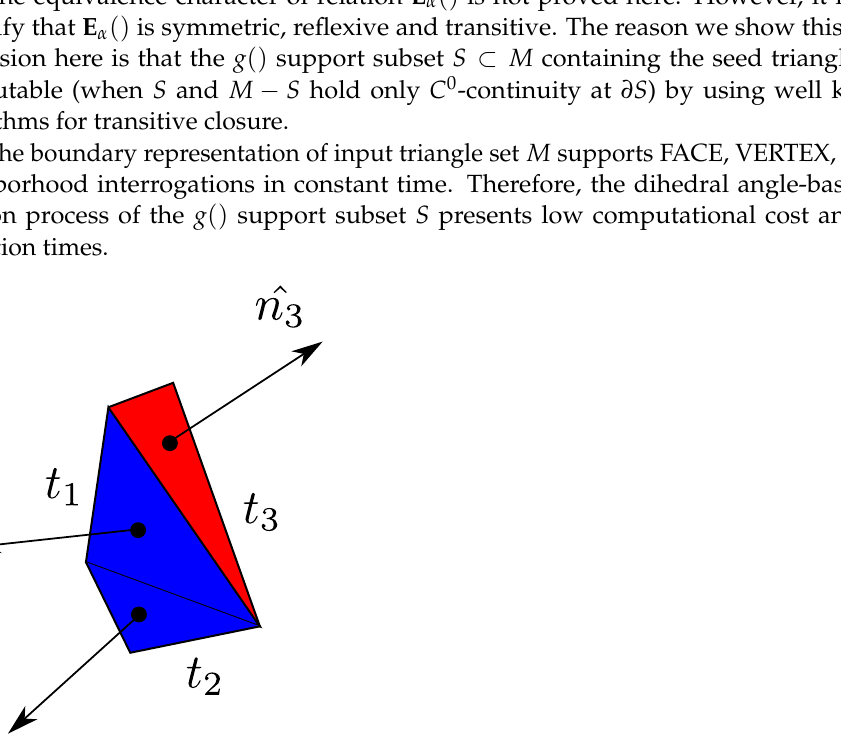
Figure 12. Dihedral angle equivalence E α () . ∠ ( n 1 , n 2 ) → 0 and E α ( t 1 , t 2 ) (blue equivalence class). ∠ ( n ) > α max and t 3 (red) is outside the equivalence class (blue) of t 1 and t 2 1 , n 3